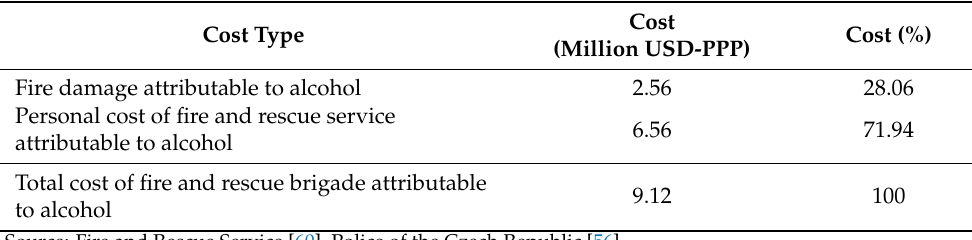
Table 13. Fire damage and cost of fire and rescue services attributable to alcohol,